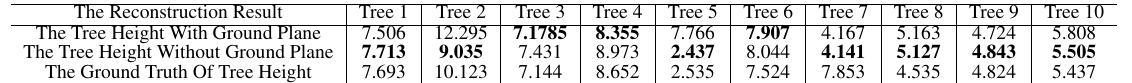
Figure 14. The label of each tree. There are about ten tree in the power site, the detection of different reconstruction results are shown in the table 2 and the figure 16 and 17 Table 2. The Detection Of Tree